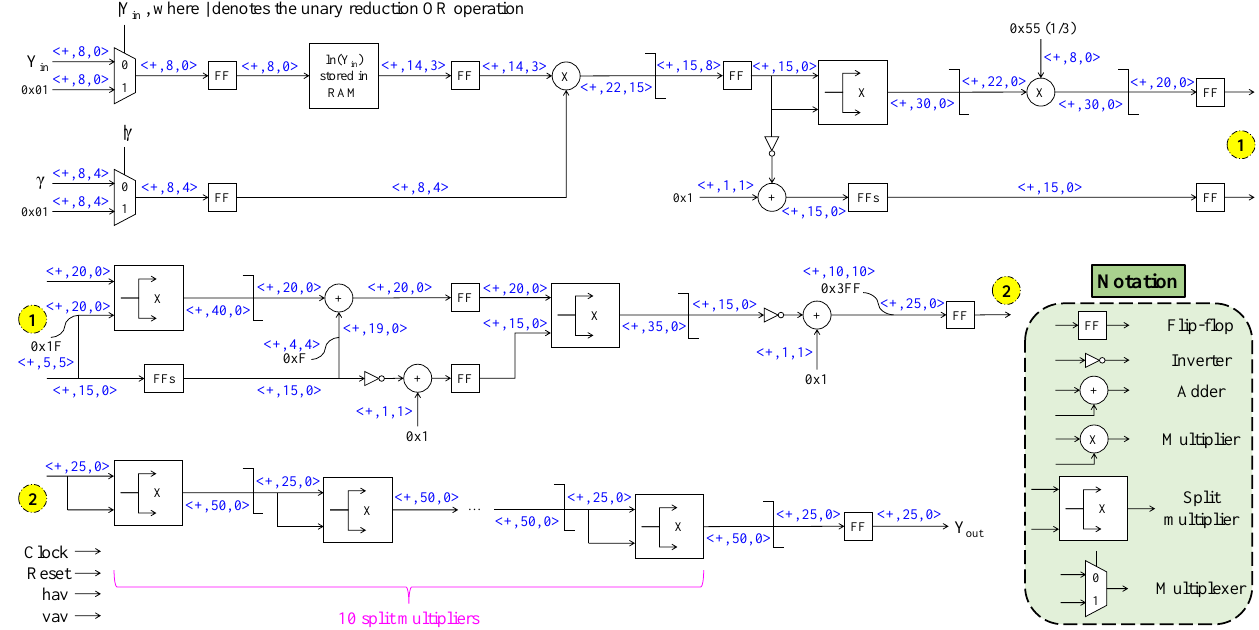
Figure 7. Data path of the run-time reconfigurable gamma correction with explicit word length information. Clock, reset, hav, and vav denote the clock, reset, horizontal active video, and vertical active video